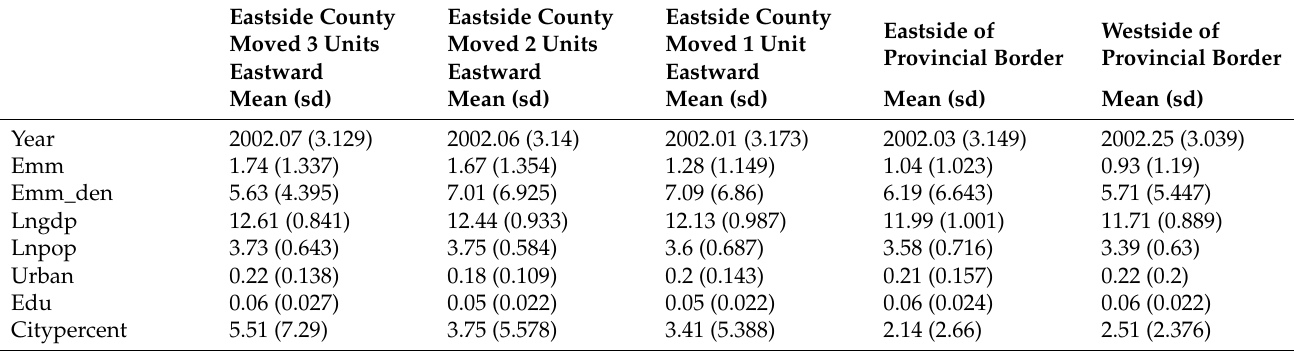
Table A1. Group Statistical Tests (Mean & Variance).